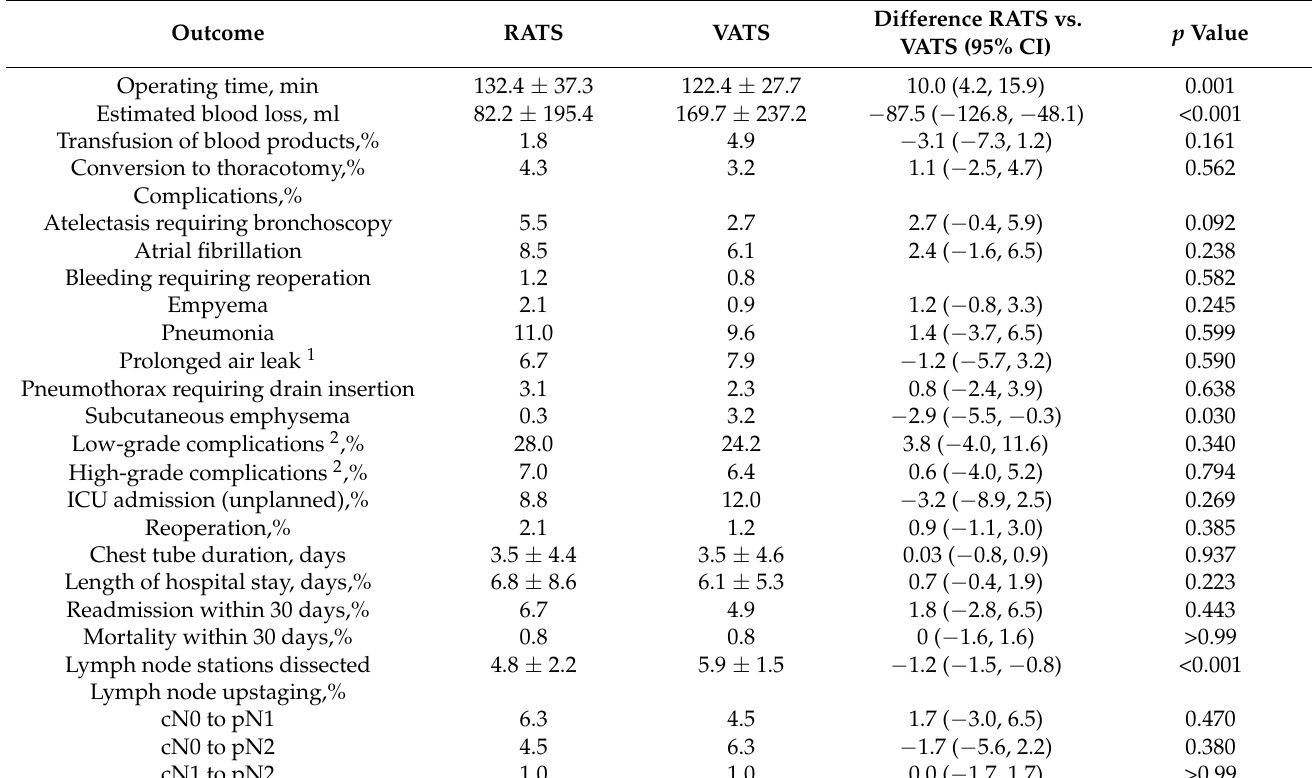
Table 3. Surgical outcomes after propensity